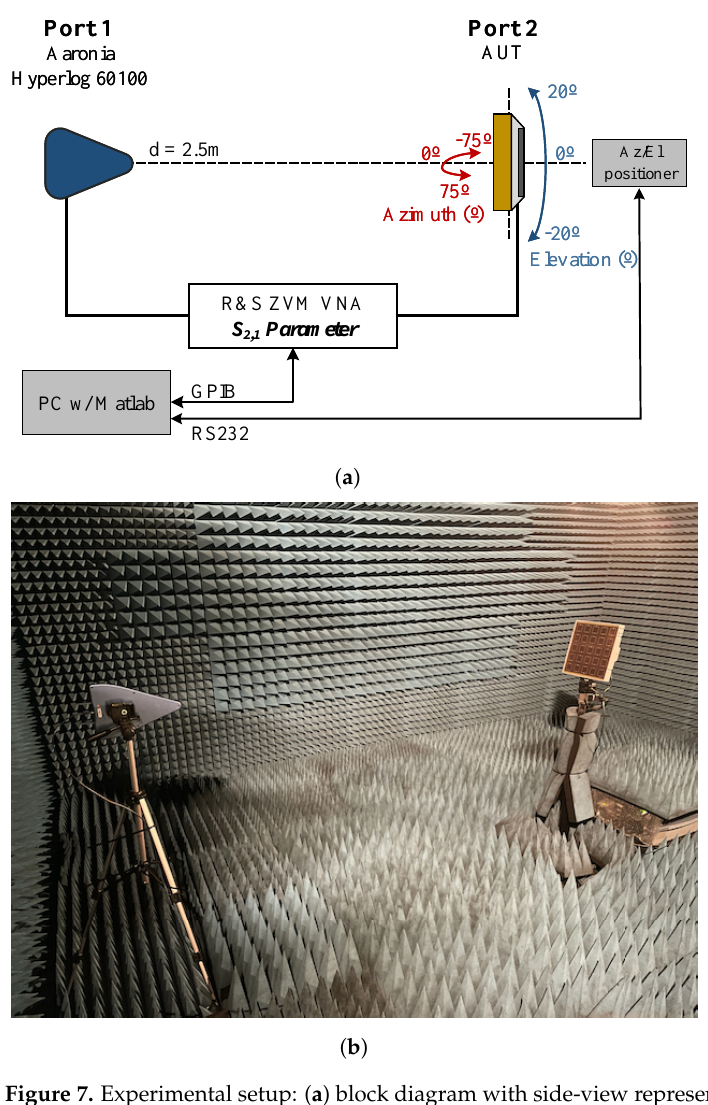
Figure 7. Experimental setup: ( a ) block diagram with side-view representation and ( b ) photography of the setup inside the anechoic